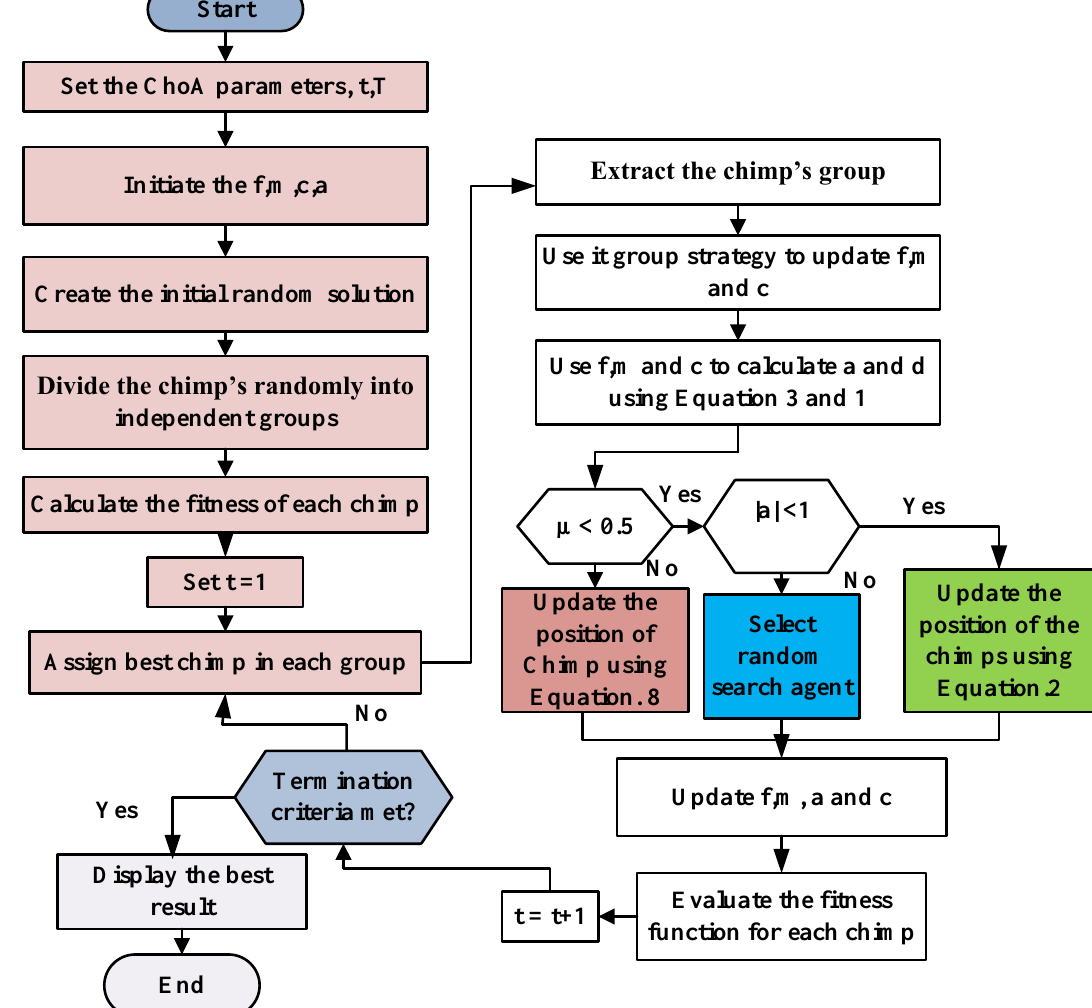
Figure 5. Schematic flowchart of the chimp optimization algorithm.